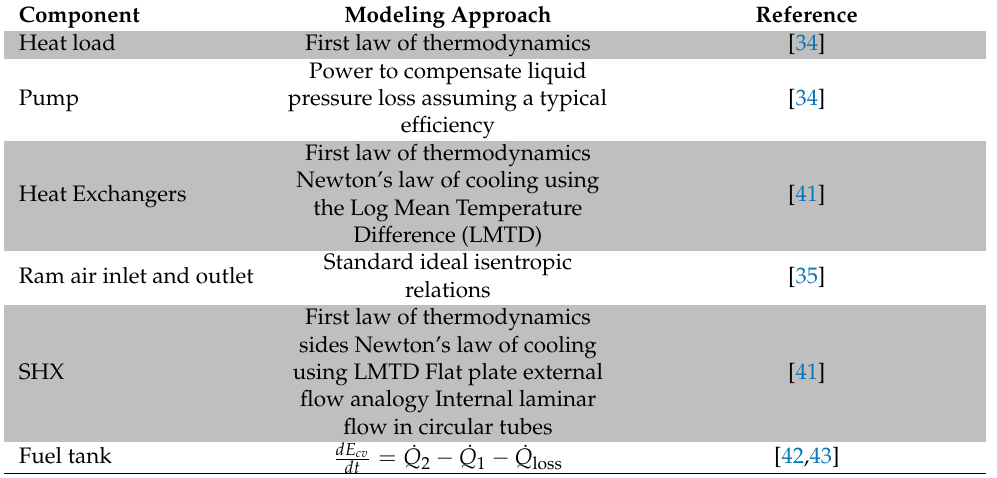
Figure 5. Proposed TMS Architecture 5. Regarding the fuel tank, the following nomenclature is considered: the heat fluxes entering and leaving are represented by ˙ Q and the fuel mass flows are represented by ˙ m [40]. Table 5. Component methodology summary. Regarding the fuel tank modeling the following nomenclature is considered: the energy of the control volume is denoted by E cv ; the heat fluxes entering and leaving the fuel tank are represented by ˙ Q 2 and ˙ Q 1 , respectively; and ˙ Q loss stands for heat flux